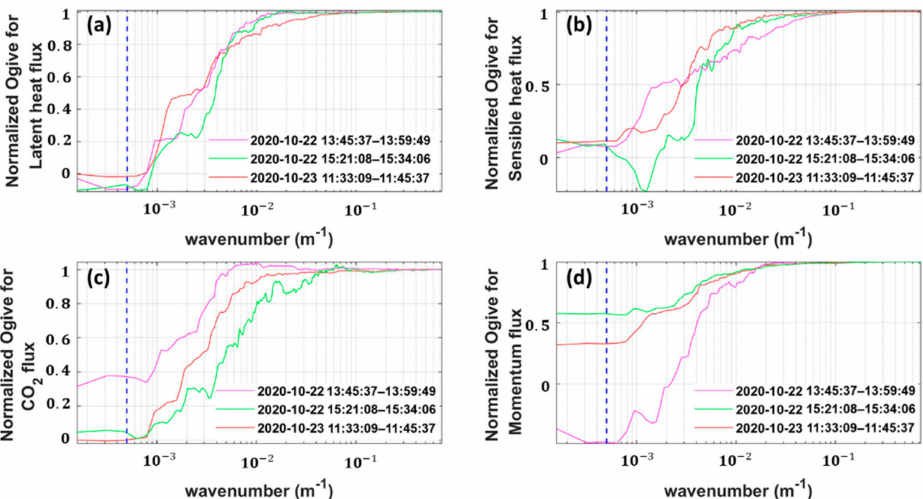
Figure 12. Normalized Ogive curves as a function of wavenumber for latent heat flux ( a ), sensible heat flux ( b ), CO 2 flux ( c ) and momentum flux ( d ) from the comparison flights. The vertical black dotted line indicates the wavenumber position of the selected spatial average length of 2 km for flux calculation.